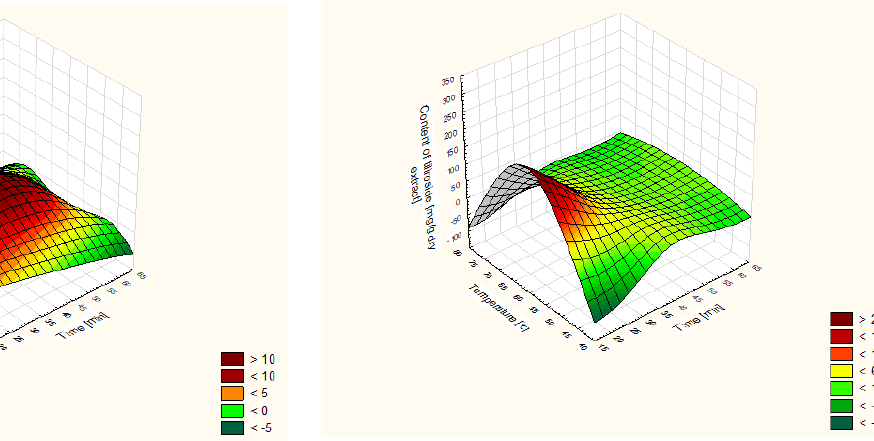
Figure 4: Surface chart 3W of the content of tiliroside vs. temperature and time of extraction (for 10% ethanol concentration) (Smoothing of smallest squares weighted by distance).